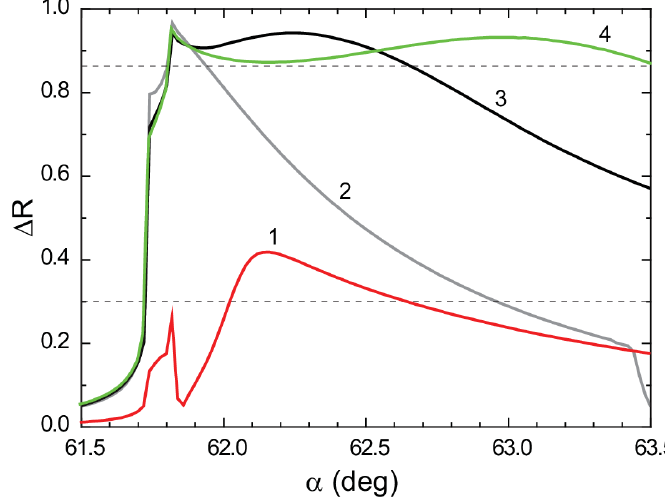
Figure 4. Comparison of the sensors’ optical response at ∆ n = 1 × 10 − 3 . Lines 1–4 illustrate the vertical sections of Figure 3a–d, respectively: the sections were made for plot (a) D = 39 nm; plot (b) ε″ = 0.8 × 10 − 3 ; plot (c) D = 12.7 nm; and plot (d) D = 8.8 nm. Dashed lines correspond to ∆ R = 0.3 and